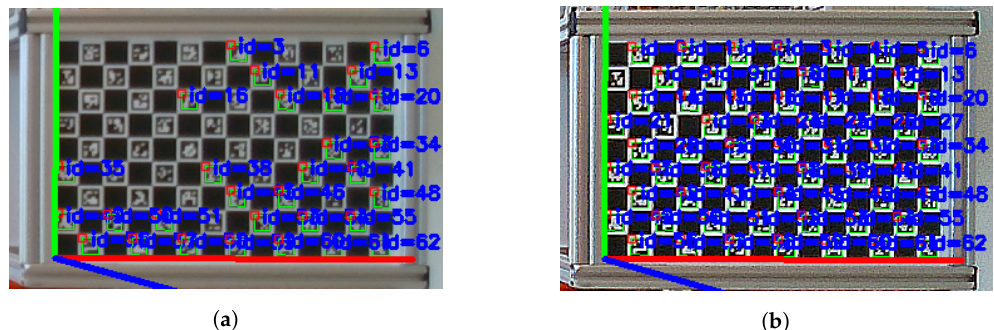
Figure 9. Use of a sharpening filter to improve ArUco recognition. ( a ) No filter applied. ( b ) Filter